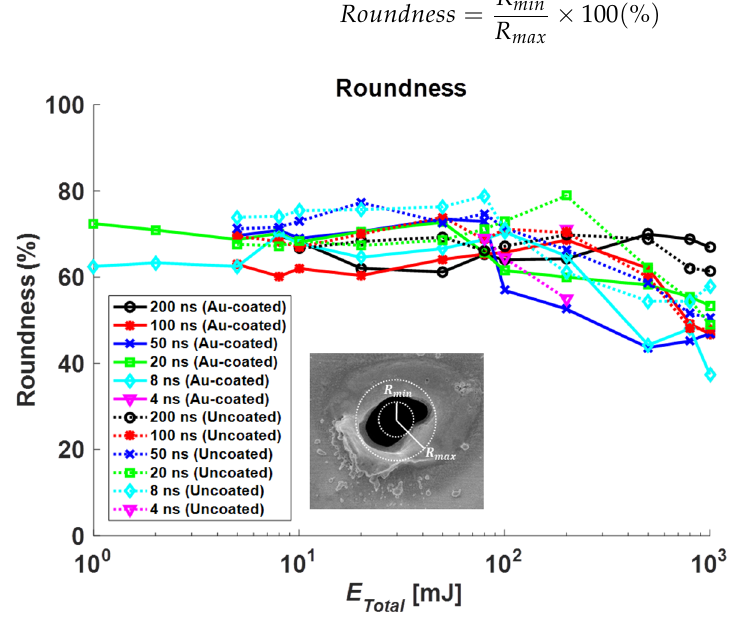
Figure 8. Roundness results under Au-coated and non-coated condition .